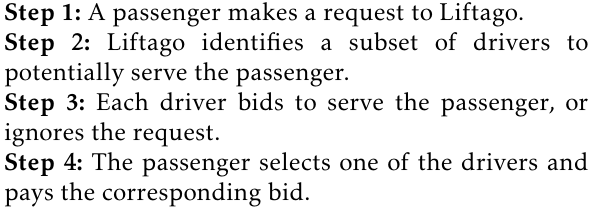
Algorithm 4 Liftago mechanism